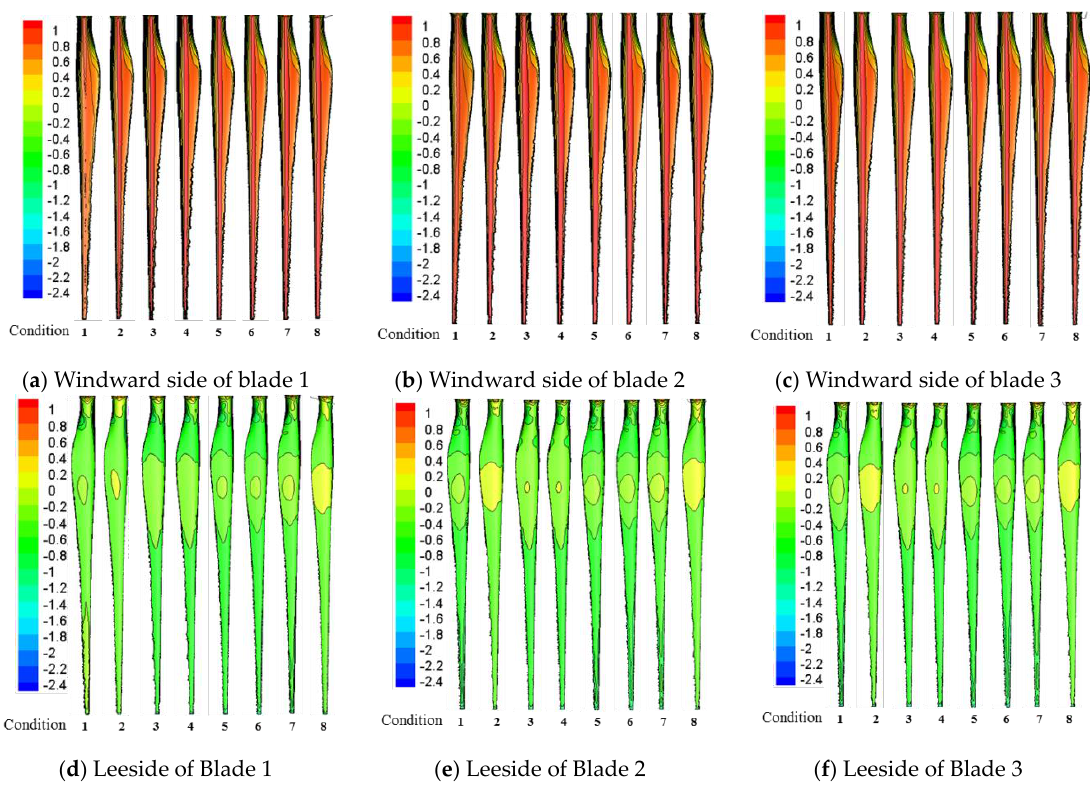
Figure 13. Pressure factor distribution on blade under different conditions.